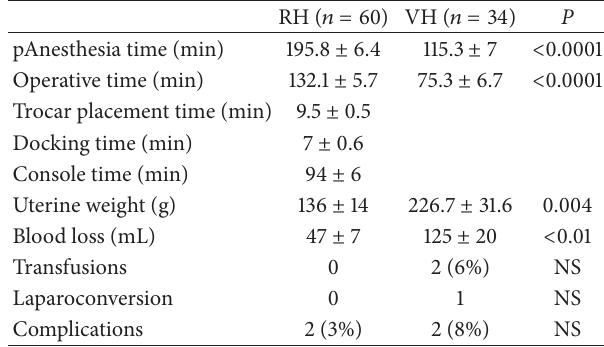
Table 2: Interoperative results expressed as mean ± SD and number